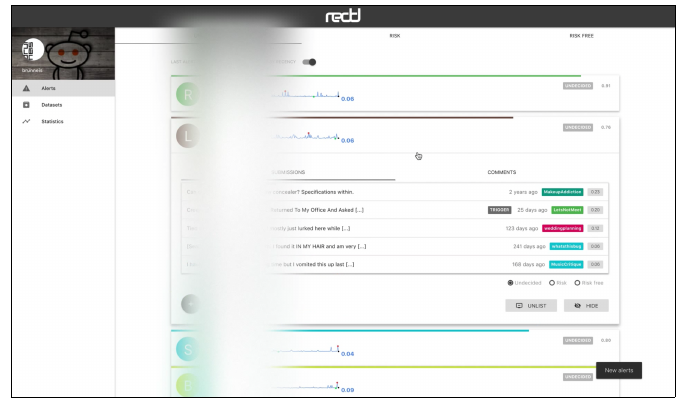
Figure 6. View to inspect the user’s submissions that generated a given alert (user data have been obfuscated).